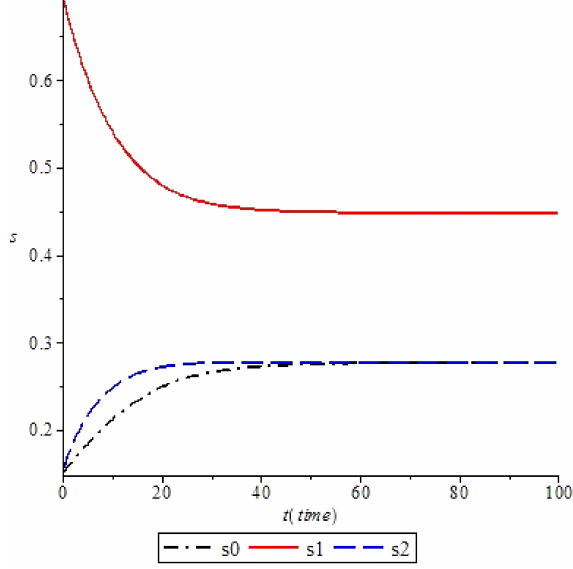
Fig. 3. Graphs of the optimal distribution of investment resources.